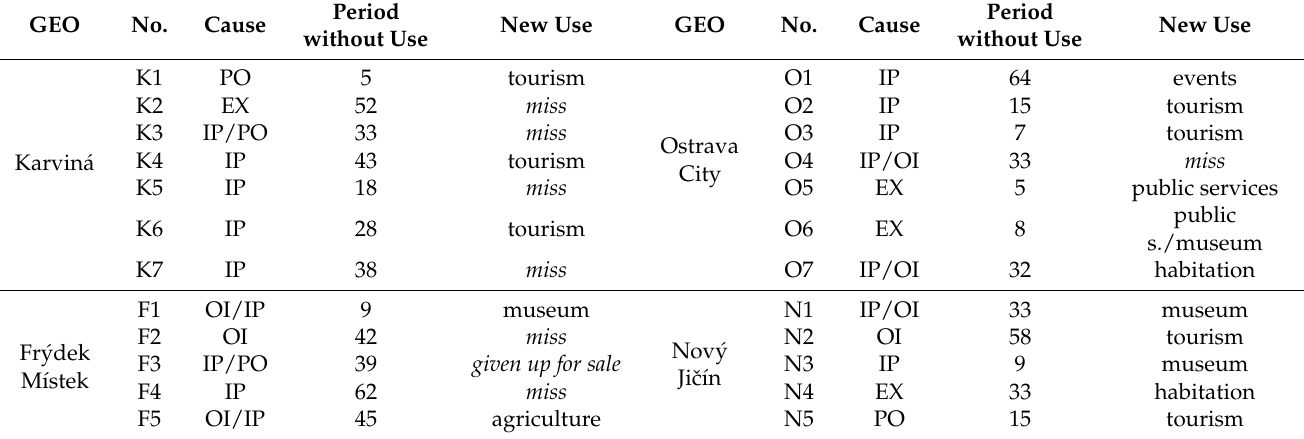
Table 3. Cause of brownfield, length of abandonment (in years), and new purpose